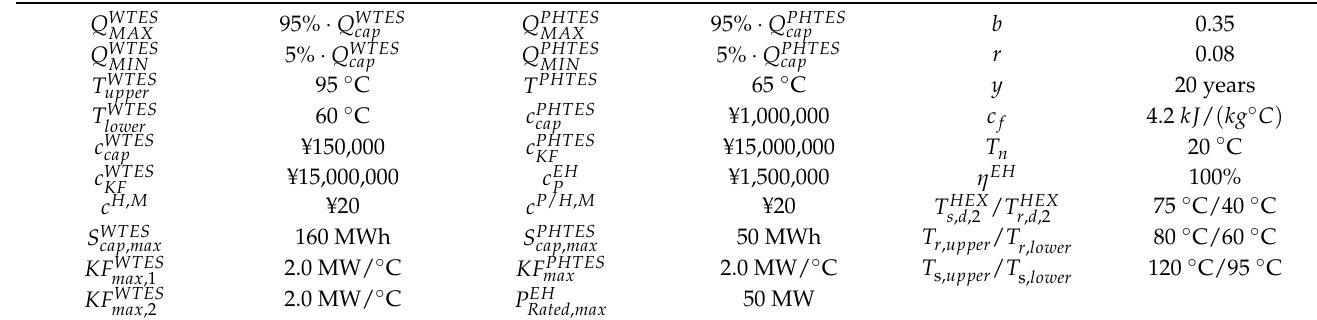
Table A4. Parameter values in the optimization process.